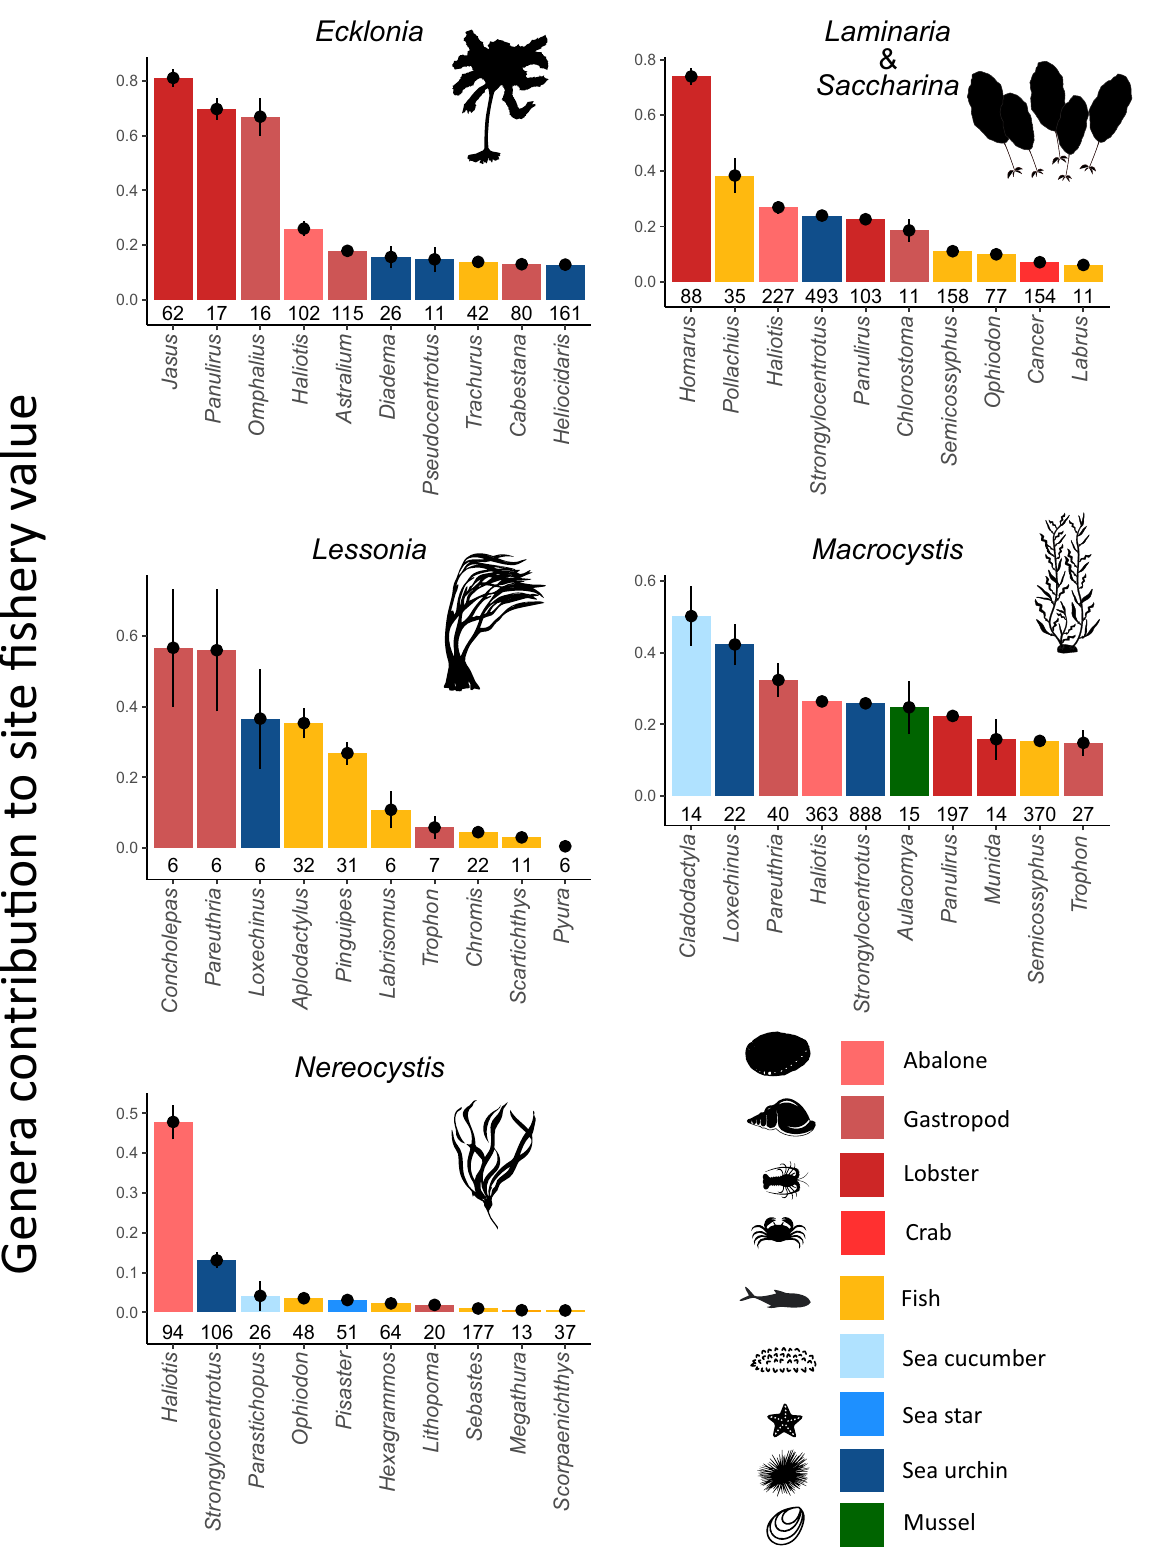
Fig. 2 | Individual genera contributions to the economic value of study sites. The mean proportion each genus contributed to a site ’ s overall fi sheries value per year, the lines represent plus and minus one standard error. The sample size is above the genera, n = number of surveys a genus appeared in, only genera